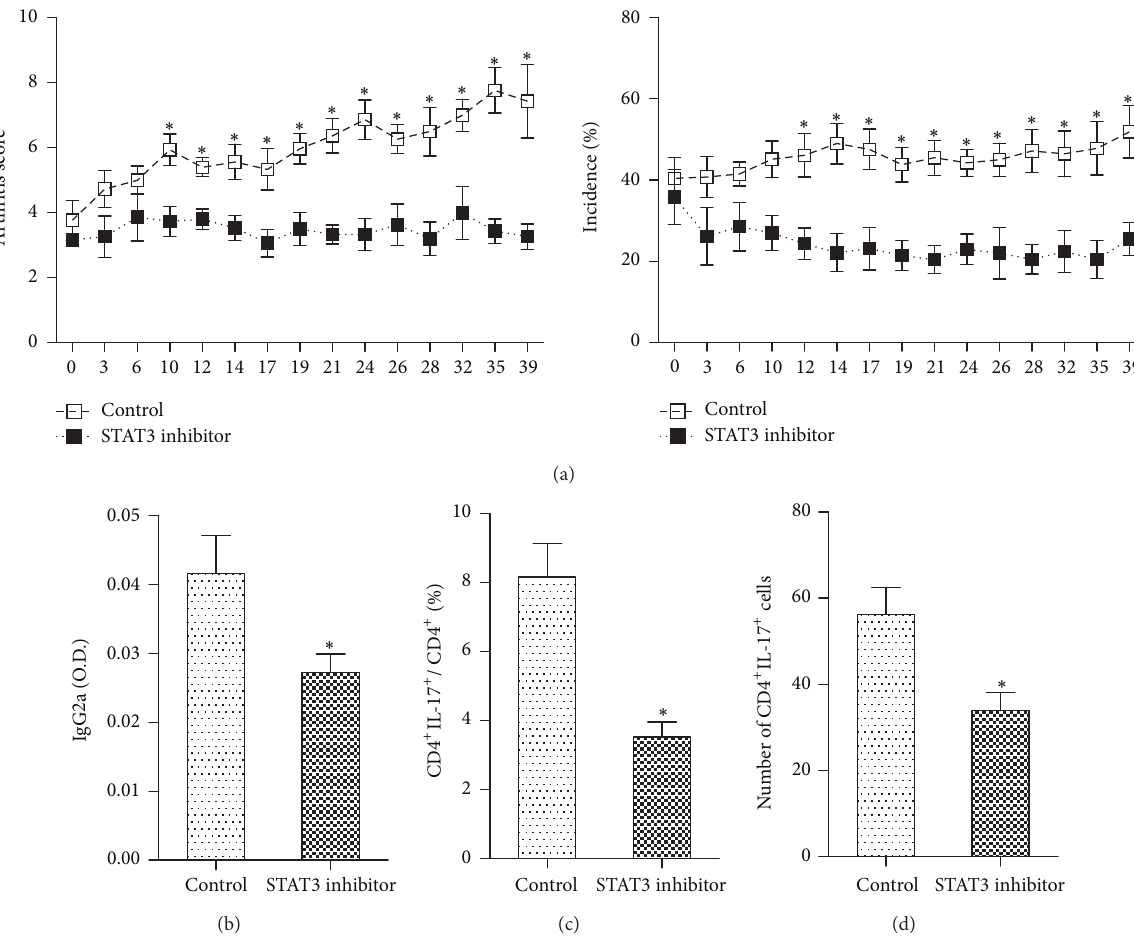
Figure 7: STAT3 inhibitor suppresses IL-17 production in mice with CIA. (a) Arthritis score and incidence of arthritis in mice with CIA following treatment with STAT3 inhibitor or control. (b) Levels of circulating IgG2a in the serum of mice with CIA. (c) Flow cytometry analysis of the synovial CD4 + IL-17 + T cell subset in mice with CIA. (d) Samples of spleen tissue from mice treated with STAT3 inhibitor or control were stained for CD4 + IL-17 + T cells. ∗ 𝑃 < 0.05 versus all other groups, 𝑛 = 6